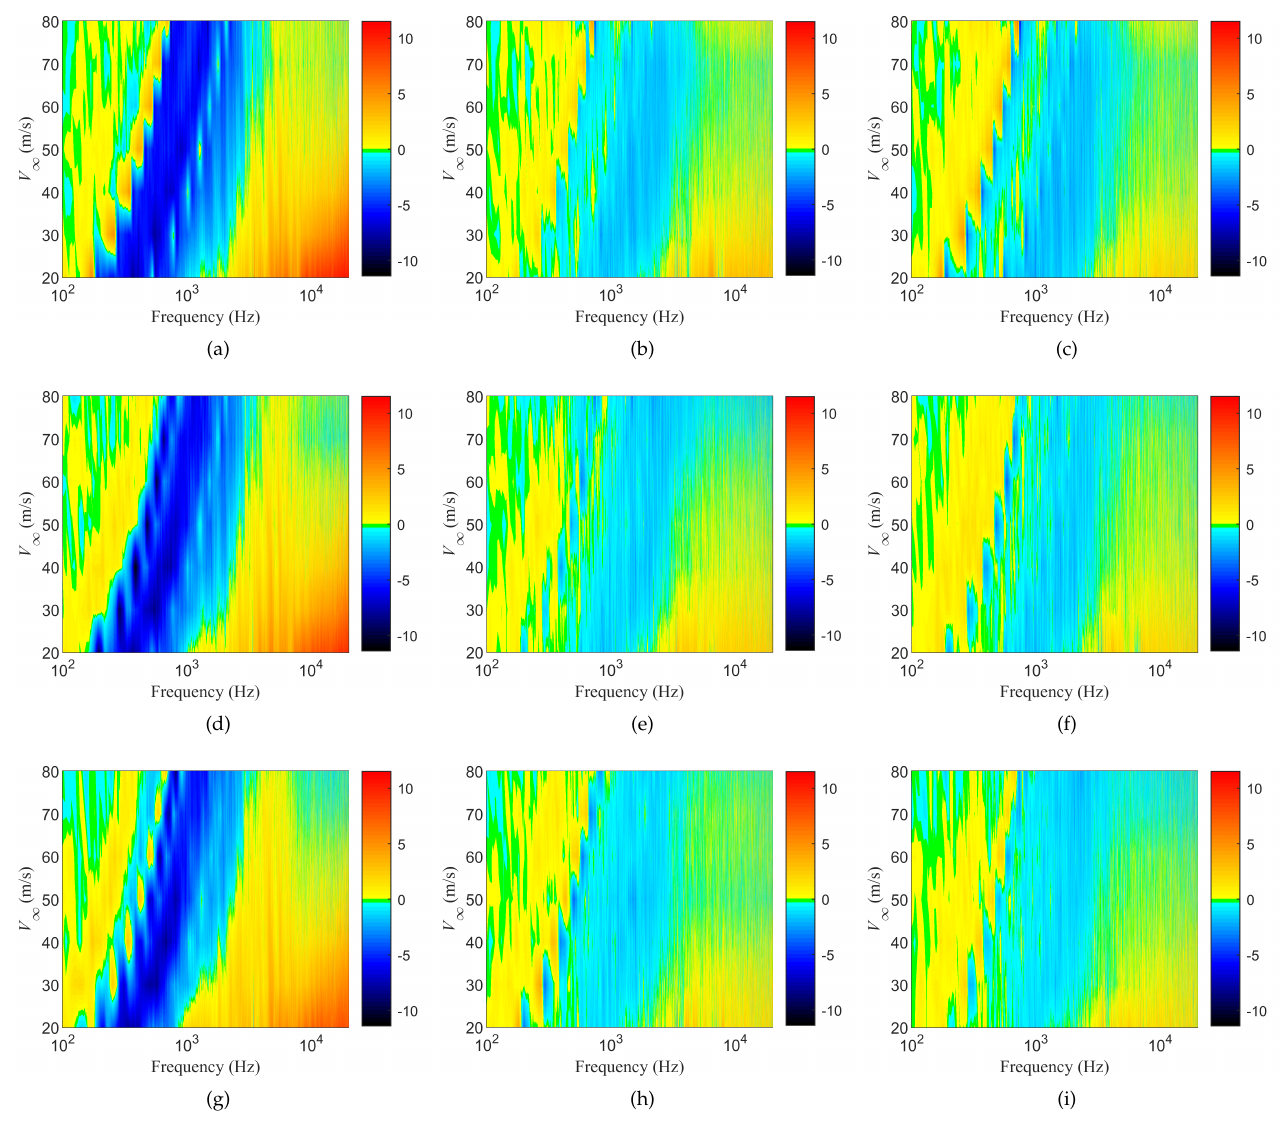
Figure 7. ∆ SPL as a function of frequency and flow velocity for different streamwise gaps for the porous leading edges with the same ppi materials ( α = 0 ◦ ): ( a ) X40Y40Z40, L = 100 mm; ( b ) X80Y80Z80, L = 100 mm; ( c ) X120Y120Z120, L = 100 mm; ( d ) X40Y40Z40, L = 140 mm; ( e ) X80Y80Z80, L = 140 mm; ( f ) X120Y120Z120, L = 140 mm; ( g ) X40Y40Z40, L = 200 mm;